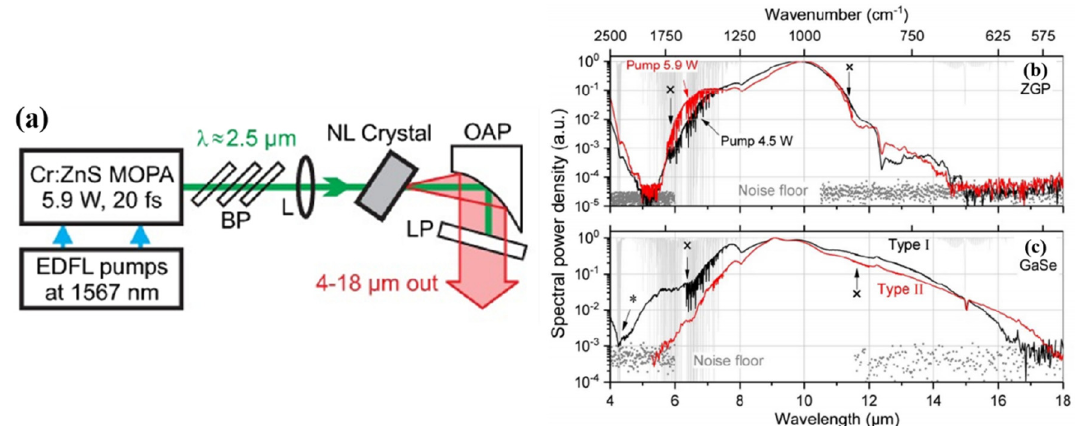
filter; P, power meter; OAP, off-axis parabola; FB, MIR fiber; M, MIR monochromator with MCT detector. Reprinted with permission from [63].